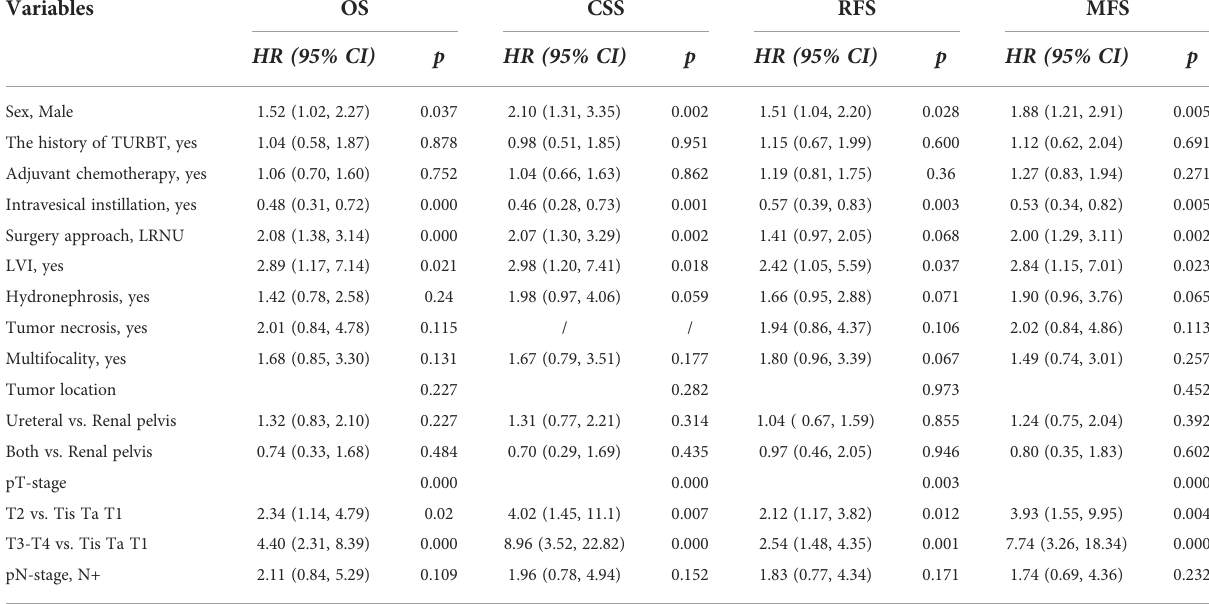
TABLE 3 Multivariate Cox proportional hazard regression analysis of the risk factors of UTUC. Variables